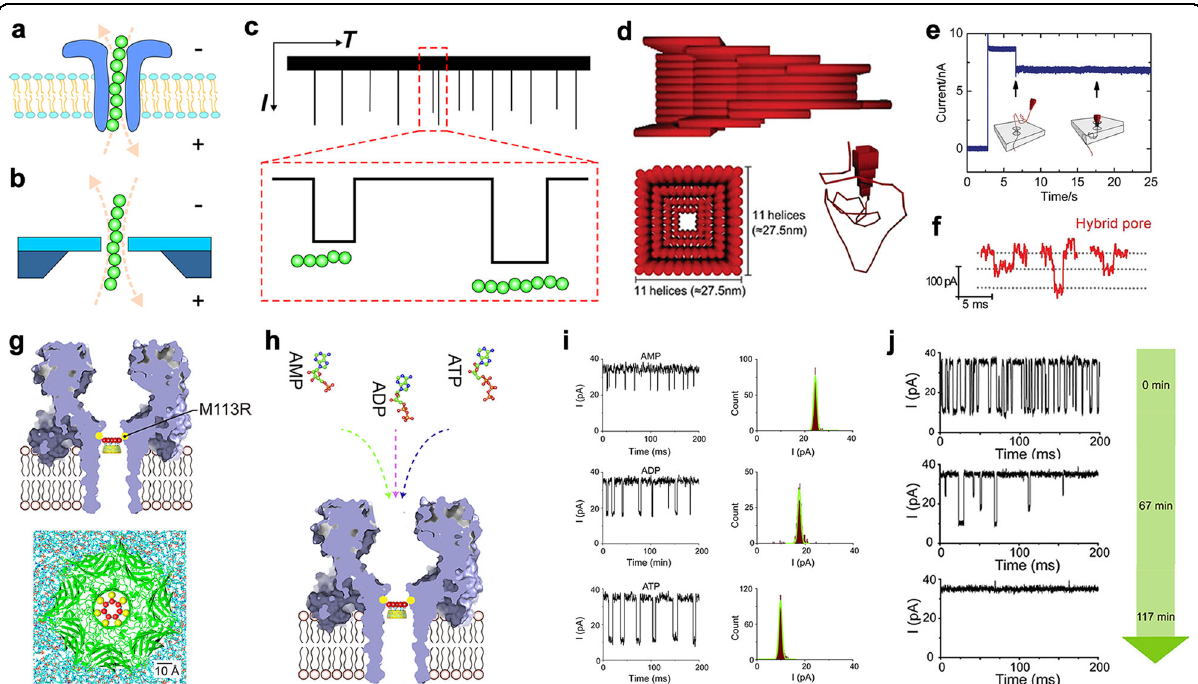
Fig. 10 Hybrid nanopores for single-molecule sensing. Schematic of single biological ( a ) and solid-state nanopore ( b ) sensing, and the resultant current trace ( c ) that corresponds to the molecular characteristic at the single molecule level. d Schematic representation of the DNA origami structure with a nanopore. e The formation of a hybrid nanopore under the applied voltage. f Typical λ -DNA events through the hybrid nanopore. Reproduced with permission 93 . Copyright 2012, American Chemical Society. g Schematic illustrating the α -HL mutant nanopore modi fi ed with β -CD in the lipid bilayer and the corresponding molecular model. h , i Schematic of the detection of AMP, ADP, and ATP ( h ) and the resultant representative ionic current traces and static histograms ( i ). j Representative current traces of the ionic current when monitoring the ATP hydrolysis process. Reproduced with permission. Reproduced with permission 95 . Copyright 2019, American Chemical